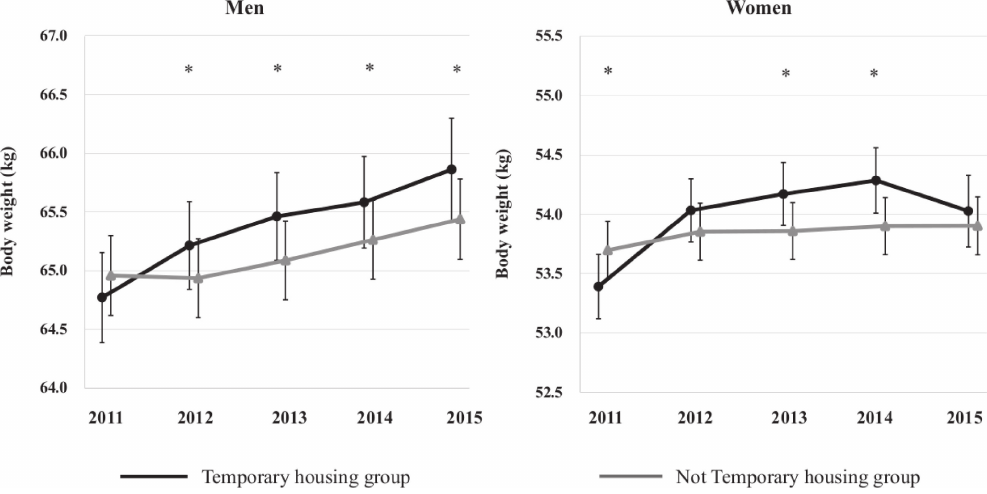
Figure 1. The trend of estimated marginal mean of body